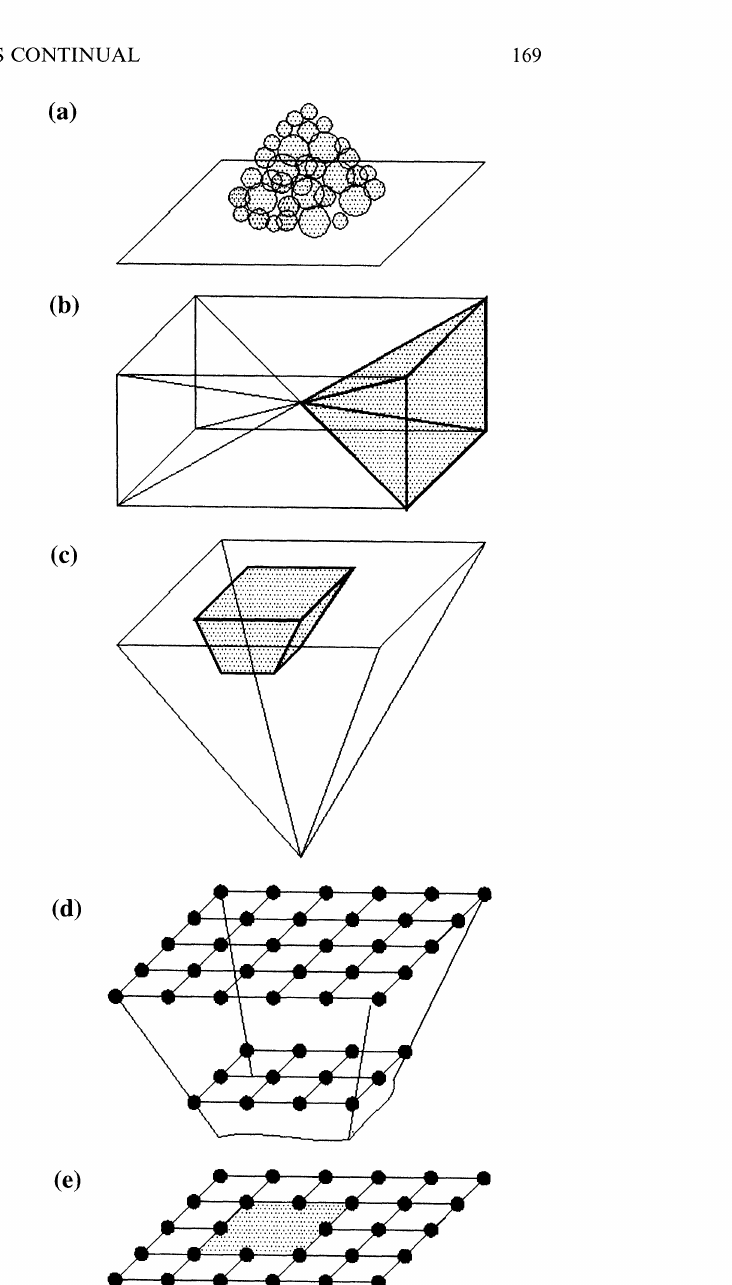
FIGURE 2 The main steps in passing from a polycrystalline samples to the single crystal face as a chemical individual. Explanations are given in the